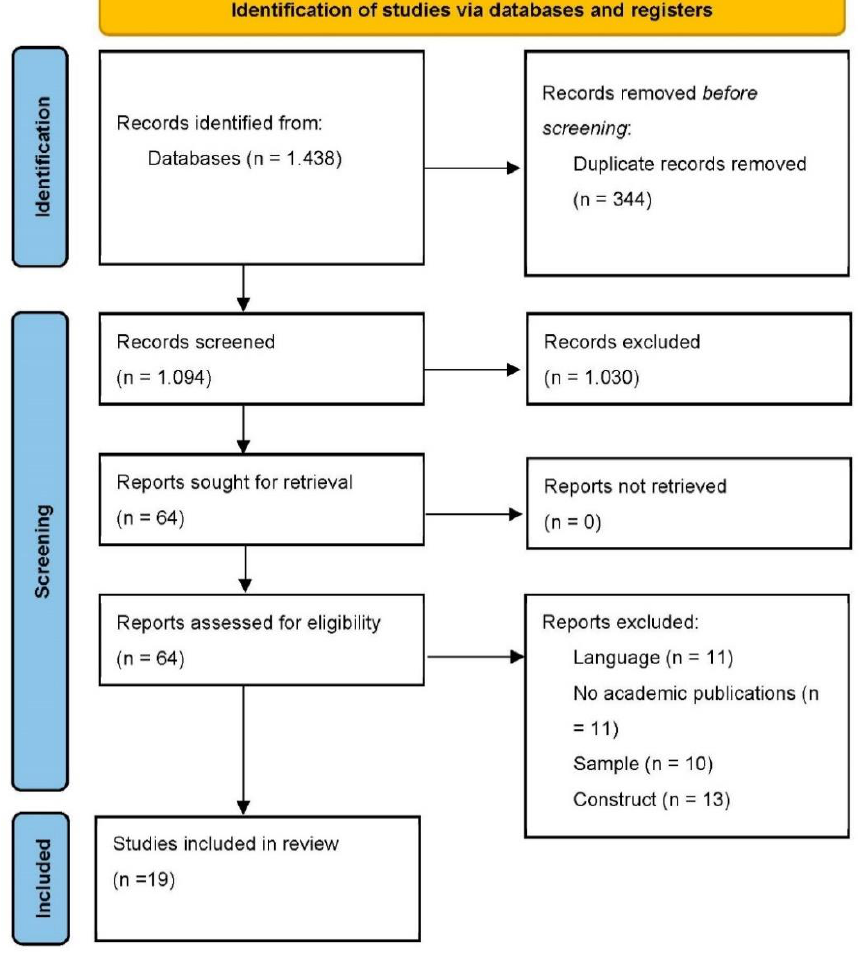
Figure 1 . PRISMA flow chart of the study selection process . Figure 1. PRISMA flow chart of the study selection